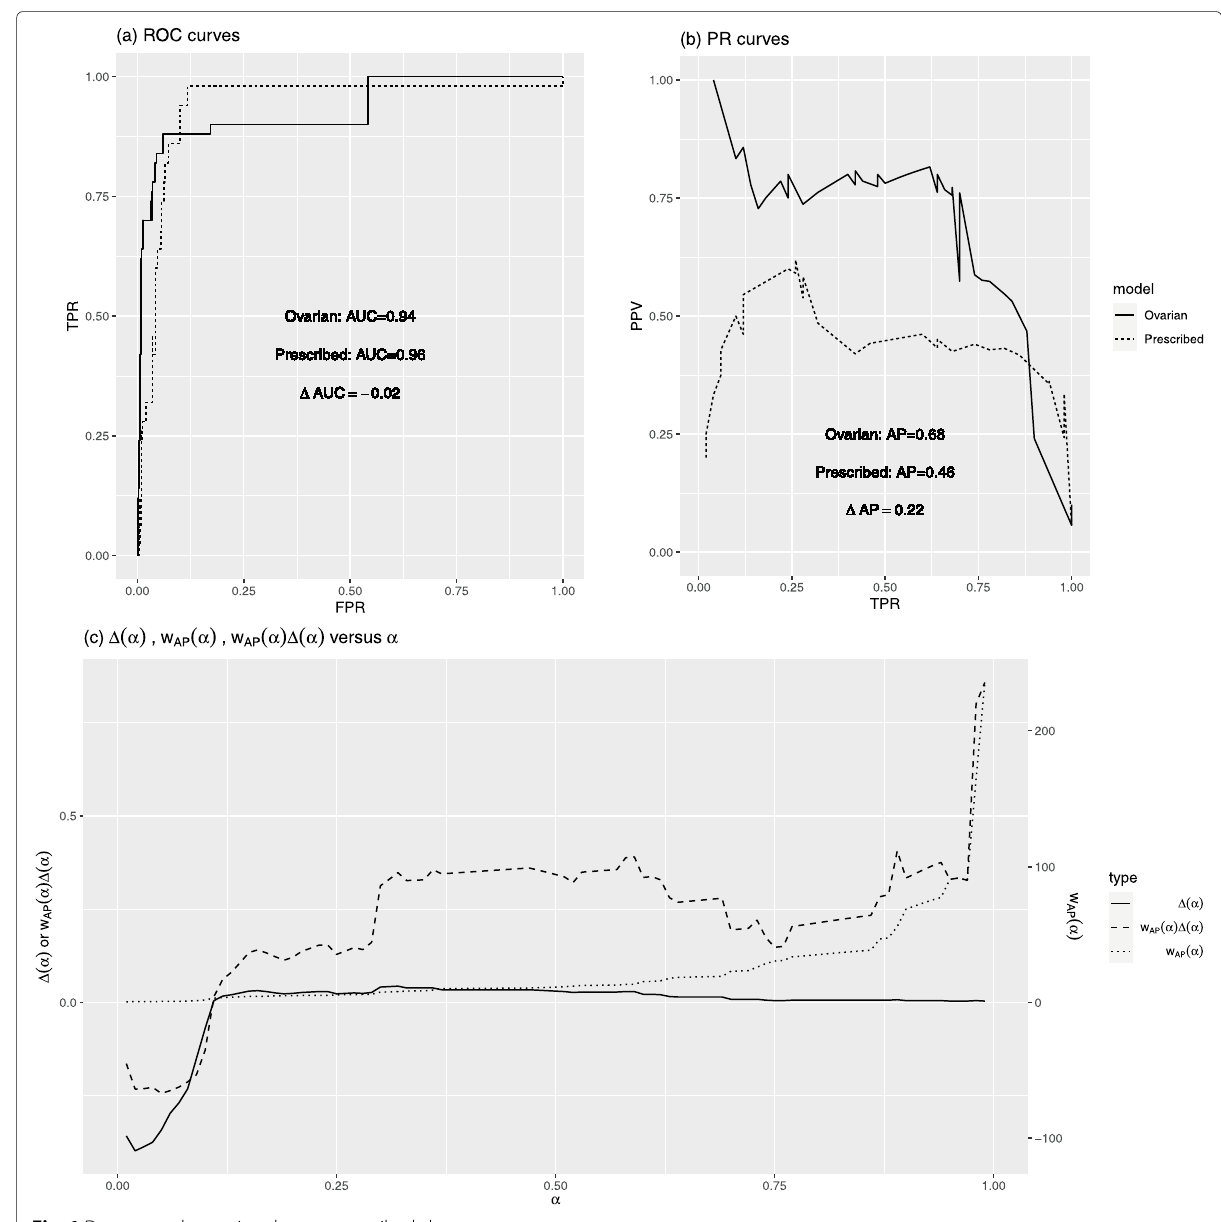
Fig. 1 Data example: ovarian-dose vs prescribed-dose